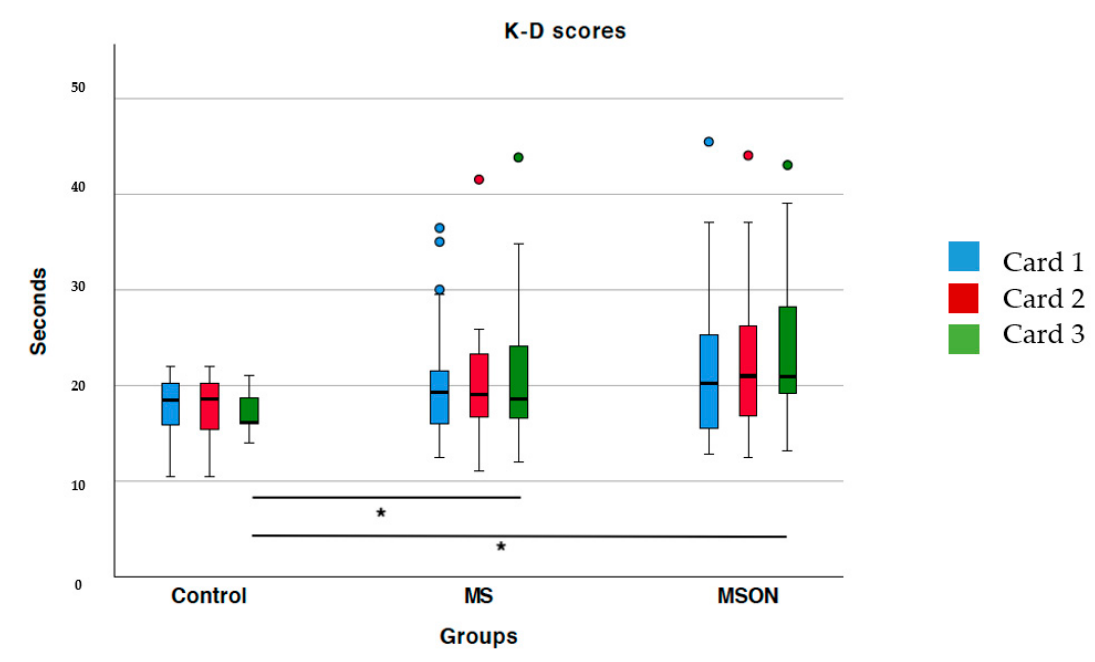
Figure 1. 2 and 3 of the K-D test per groups. Statistically significant differences were marked with an asterisk (*).